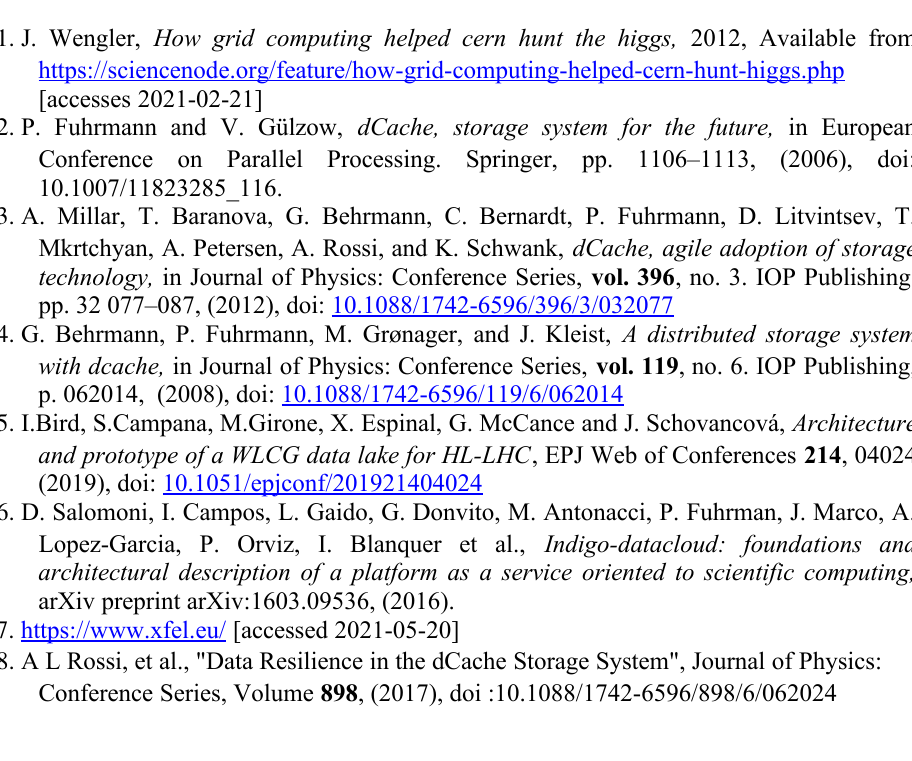
Figure 2: Small File Service operation: (1) request pushed into job